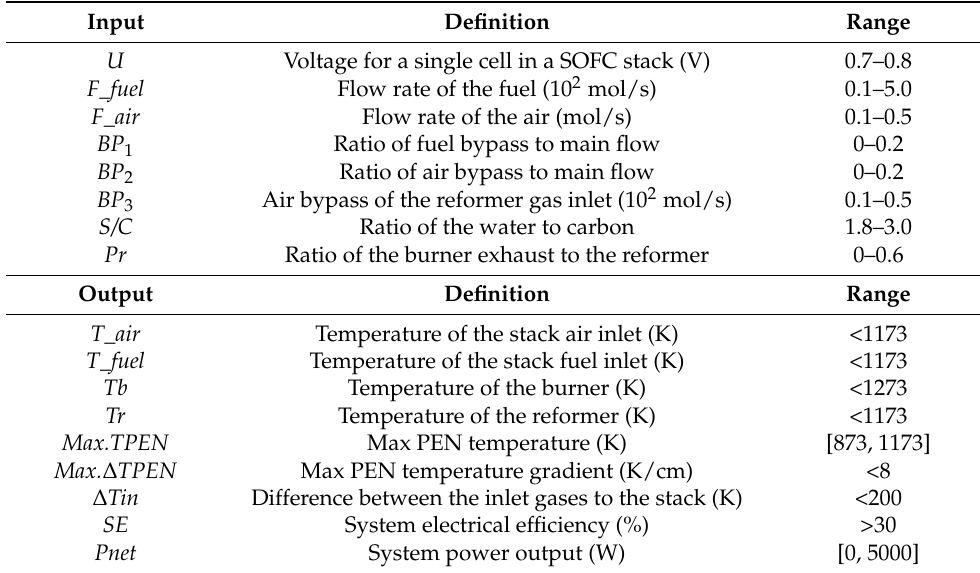
Table 1. kW-class Steam Reformer SOFC System Input and Output Ranges [27,28,30,31].